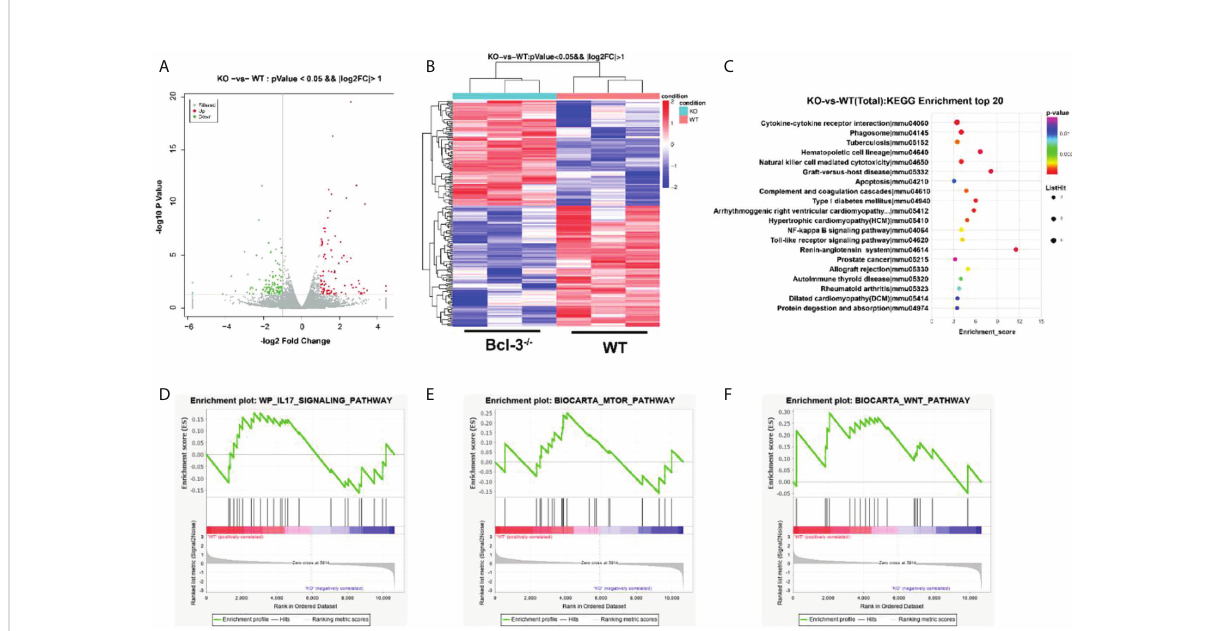
FIGURE 5 Bcl-3 modulates gene-expression programs of Th17 cells. (A) Volcano plot of transcriptomics data in Th17 cells from Bcl-3 -/- mice versus Th17 cells from WT mice. (B) Heatmaps representing genes differentially expressed ( ≥ 2-fold change, P < 0.05). (C) KEGG pathway analysis based on differentially expressed genes in Th17 cells of Bcl-3 -/- mice and Th17 cells from WT mice. The top 20 positively enriched pathways are shown in the bubble chart. (D – F) GSEA plots comparing Th17 cells from Bcl-3 -/- mice and Th17 cells from WT mice using ‘ hallmark ’ gene sets, showing the enrichment of IL-17 signaling, mTORC1 targets and Wnt